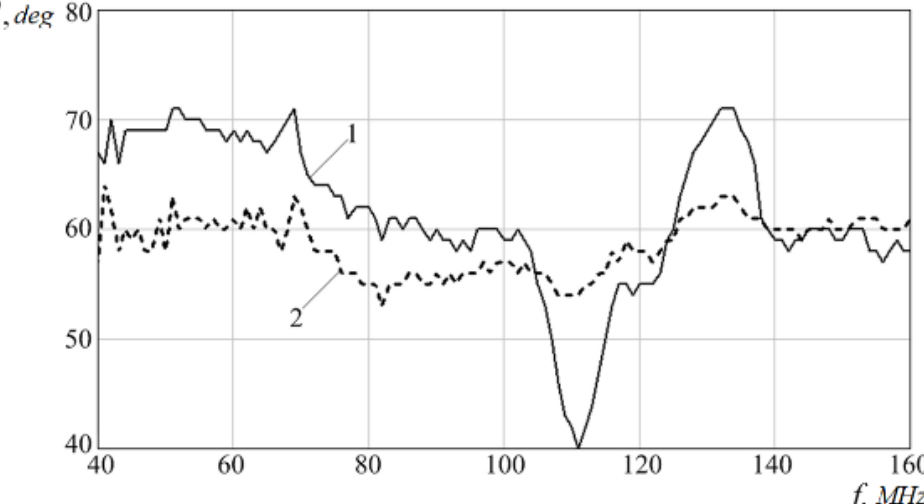
Figure 10. Experimental frequency dependences of the DOA estimates with true angle of arrival 60 ◦ . Curve 1—correlation-interferometric method; Curve 2—the VAA method.